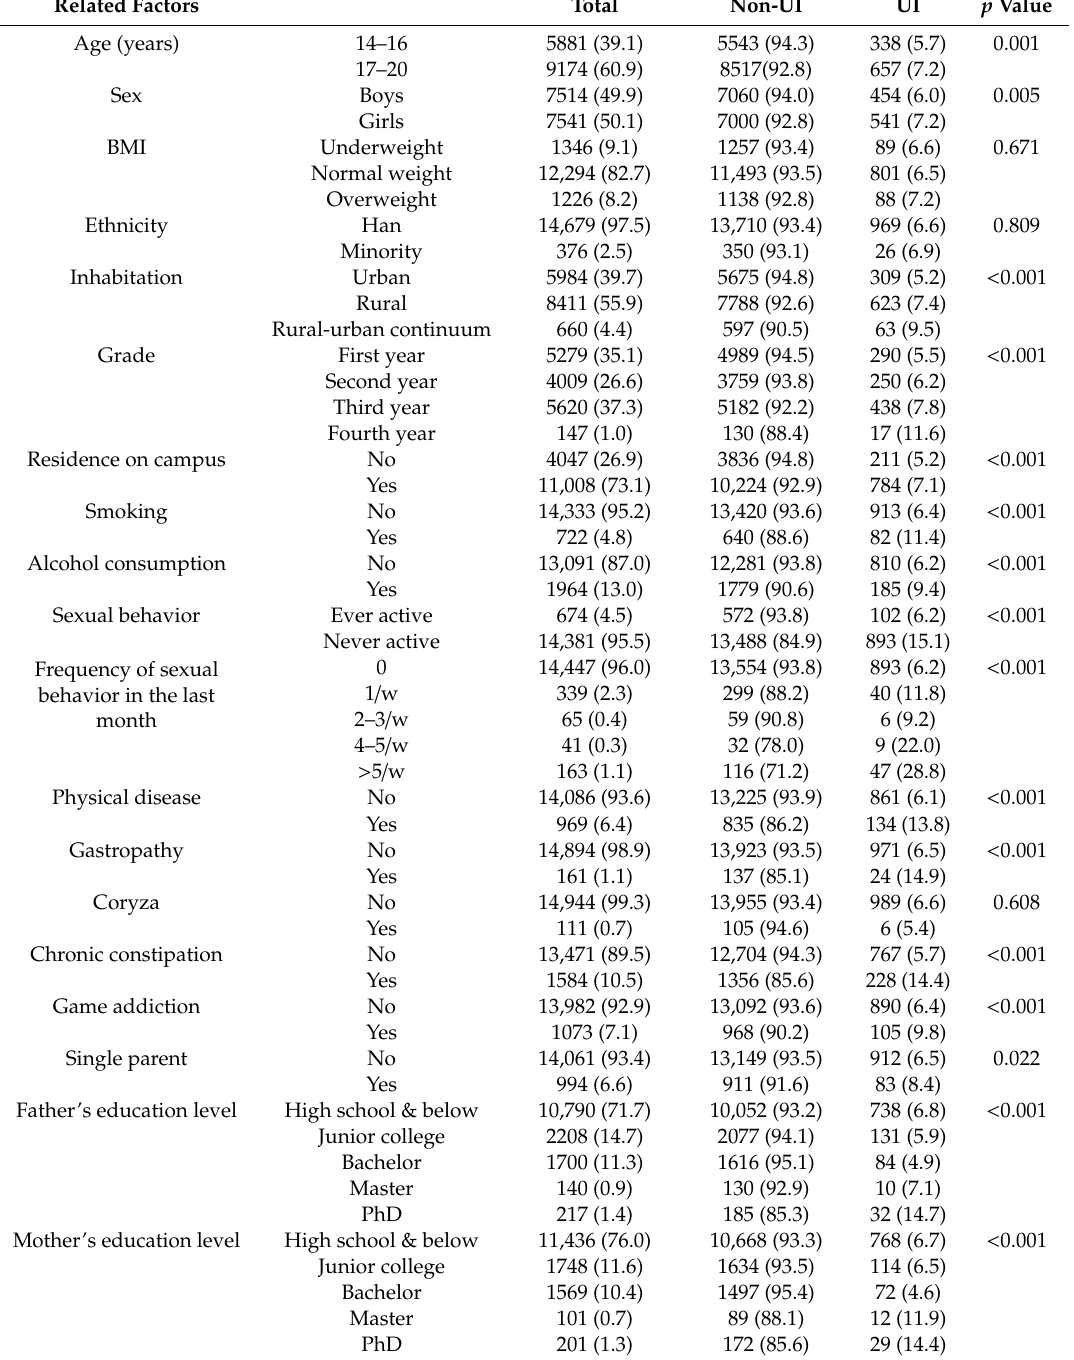
Table 1. Prevalence of UI and univariate analysis of risk